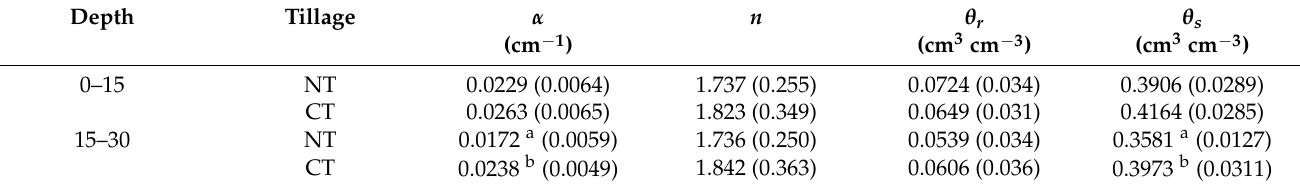
Table 1. Parameters of the van Genuchten model of the soil–water retention curve for a sandy loam soil at 0–15, and 15–30 cm depths averages under no-tillage (NT) and conventional tillage (CT). The α parameter is related to the inverse matric potential at inflection point (cm − 1 ); n is associated with pore size distribution; θ r is the residual water content (cm 3 cm − 3 ); and θ s is water content at saturation (cm 3 cm − 3 ). Each value is an average of 20 measurements (average of 4 years of data and 5 replications per treatment at each depth). After Jabro and Stevens